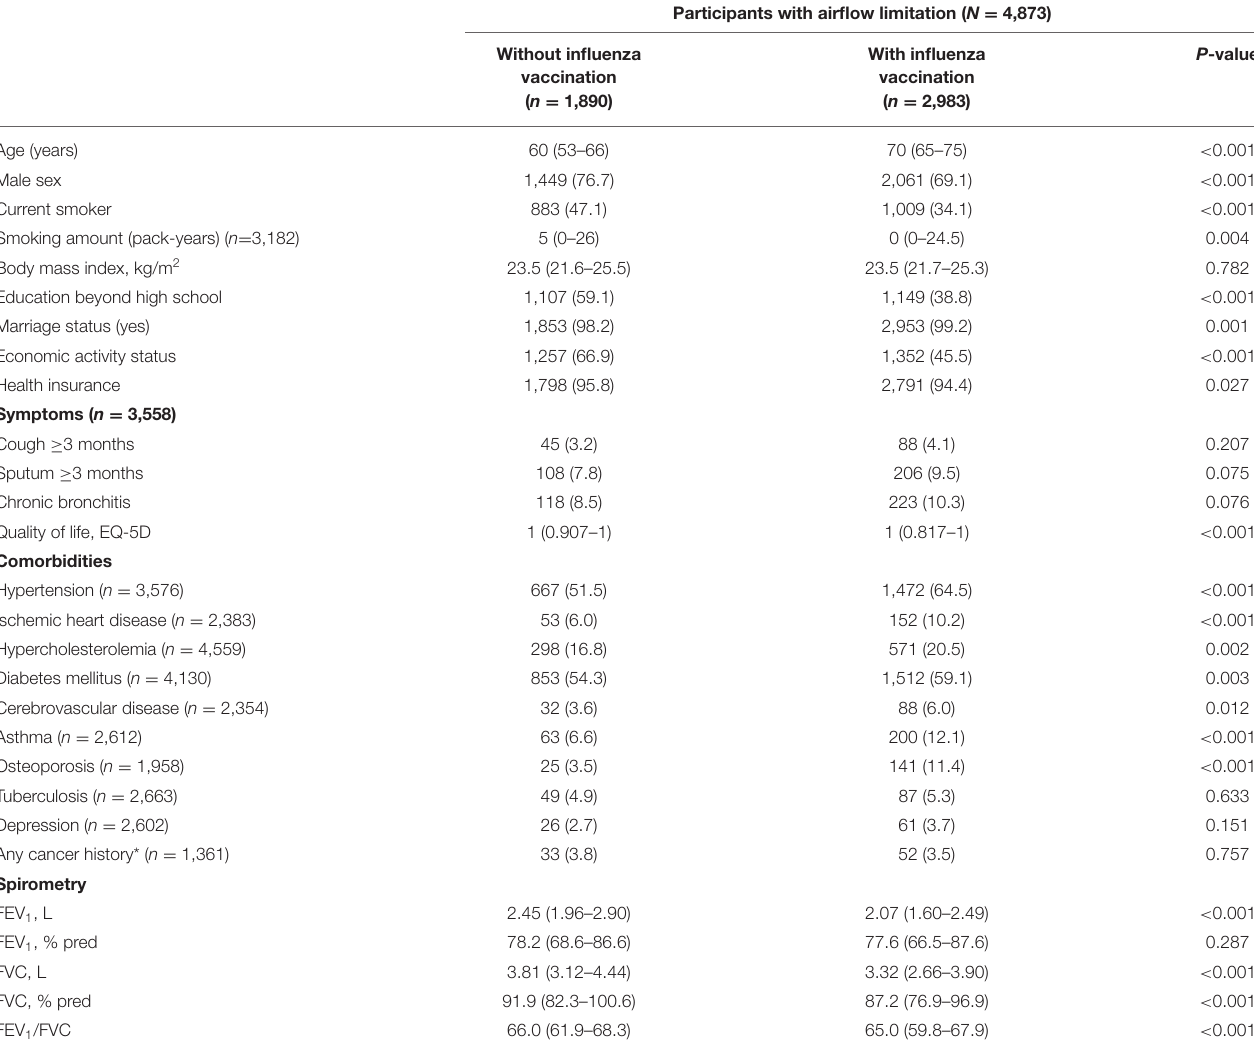
TABLE 1 | Comparison of clinical features in participants with airflow limitation according to influenza